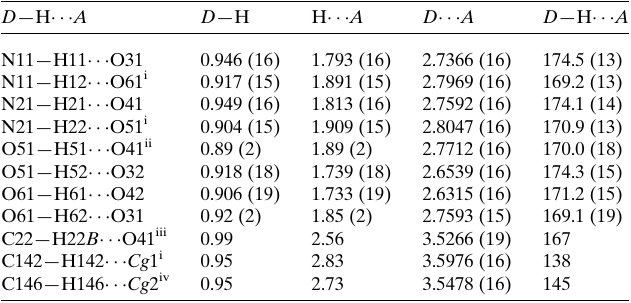
Table 1 Hydrogen-bond geometry (A˚ , (cid:4) ) for (I). Cg 1 and Cg 2 represent the centroids of the C31–C36 and C41–C46 rings, respectively.